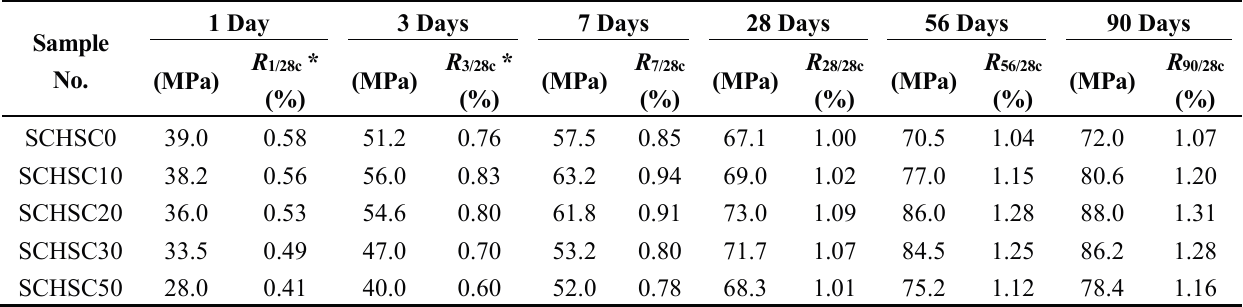
Table 5. Compressive strength and the relative compressive strength for SCHSCs.